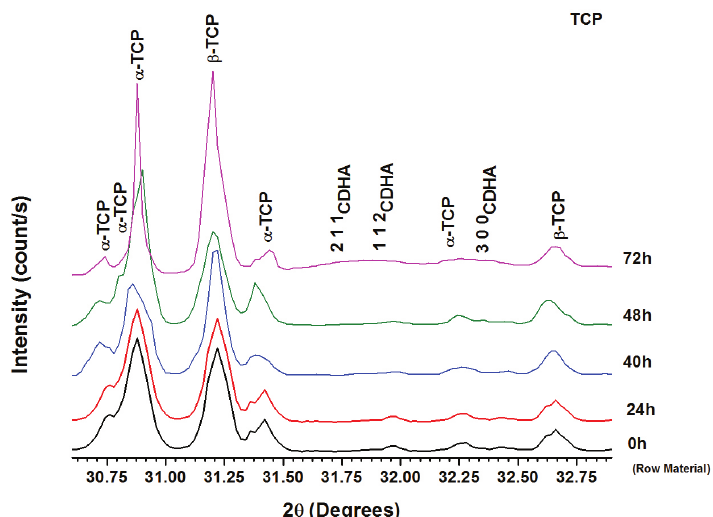
Figure 1. XRD patterns of TCP under in-situ setting condition within 72